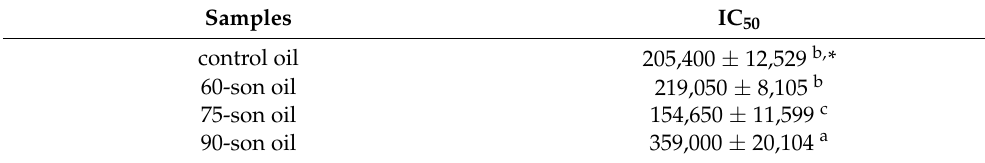
Figure 7. Increase (%) in total polyphenols after the enrichment; Standard deviation is presented with error bars and means within each month with different superscript letters (e.g., a–c) are significantly ( p < 0.05) different.